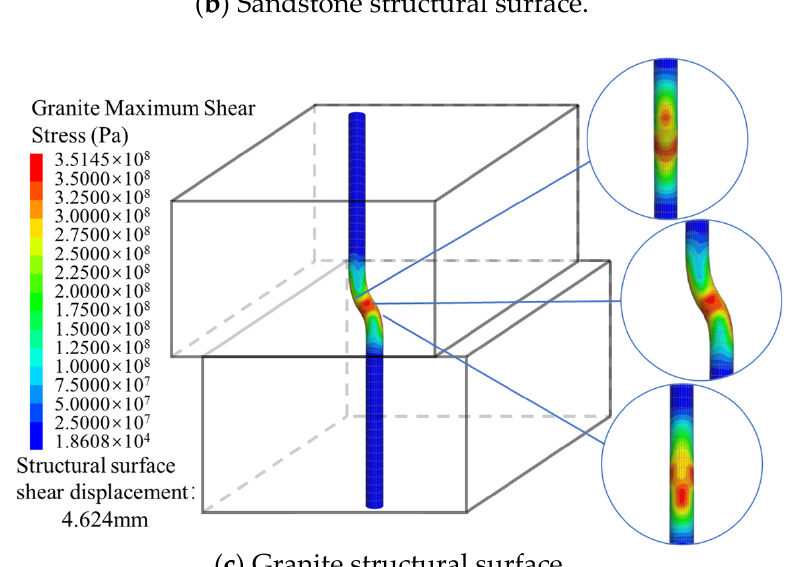
Figure 10. Maximum shear stress distribution at bolt yield (Pa).